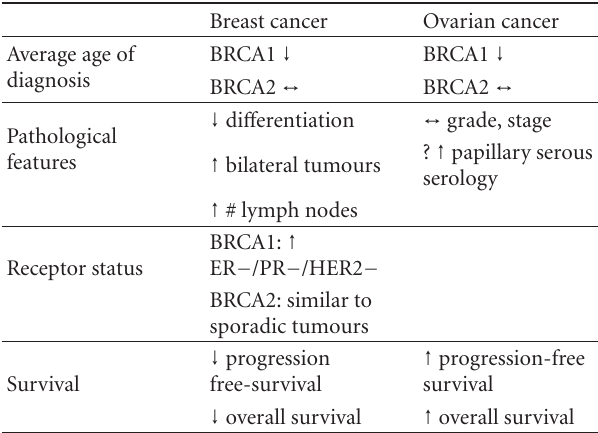
Table 1: Clinicopathologic characteristics of hereditary versus sporadic breast and ovarian